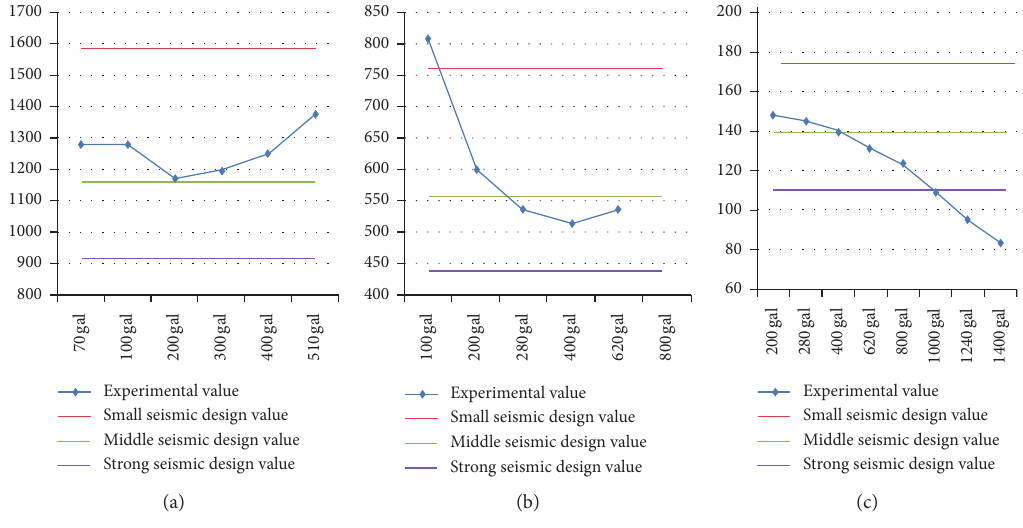
Figure 12: Equivalent horizontal stiffness: (a) MLQT-2; (b) MLQT-3; (c) MLQT-4.